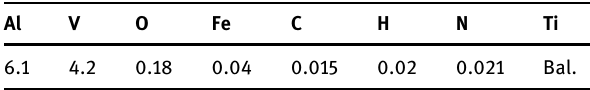
Table 1: Main components of TC4 titanium alloy powder ( wt%